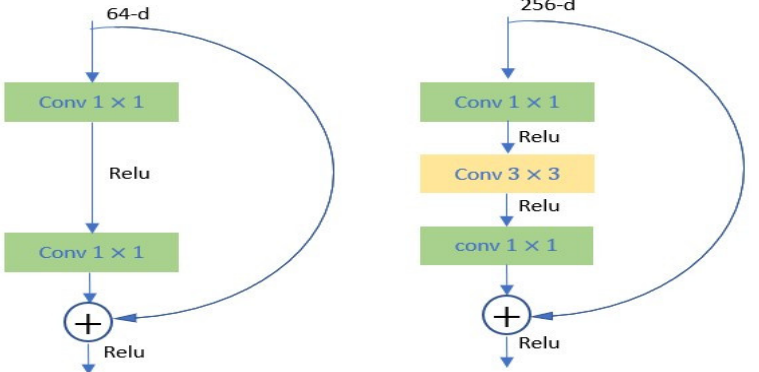
Figure 4. The function F of deep residual operation. Left: the block design for ResNet34. Right: the bottleneck block design for ResNet52 (thinner block).